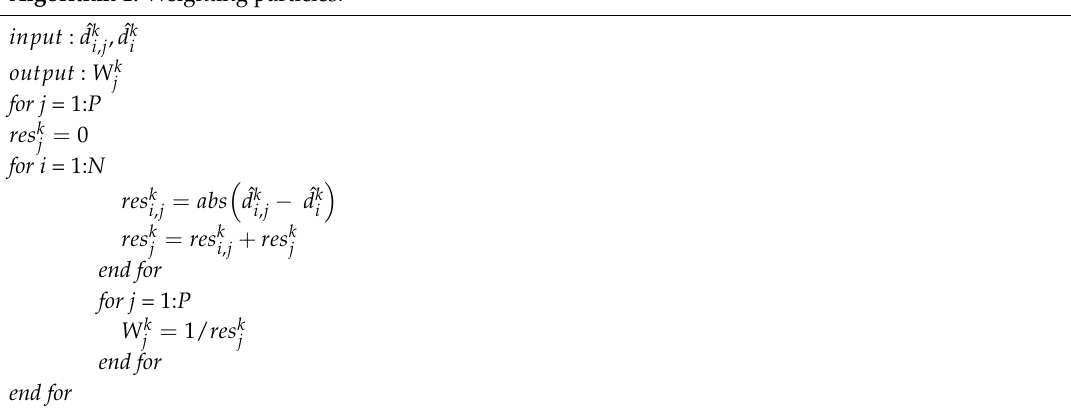
Algorithm 1. Weighting particles.